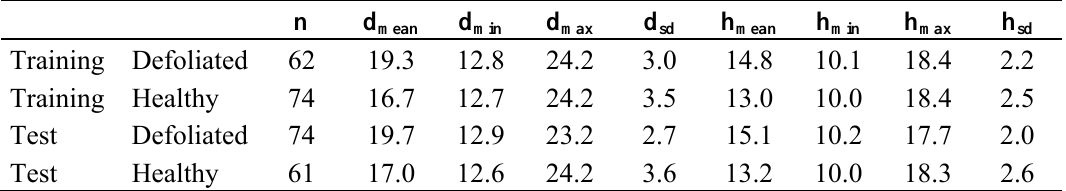
Table 1. Statistics of trees in defoliated and healthy categories, where d is the laser diameter at breast height and h is the laser height of a tree.